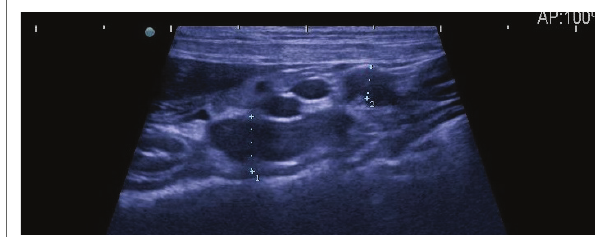
FIGURE 1: Abdominal ultrasound image of the enlarged mesenteric lymph nodes, indicated by callipers labelled 1 and 2 (measurements of 8 mm and 5 mm, respectively).